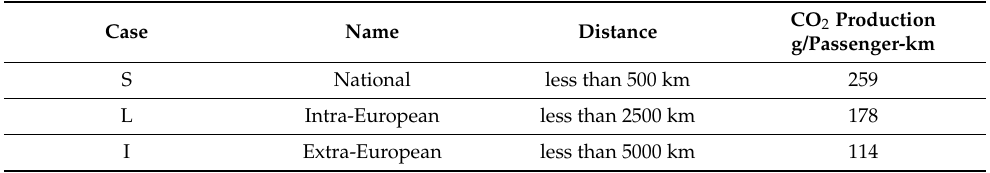
Table 2. Definition of the type of